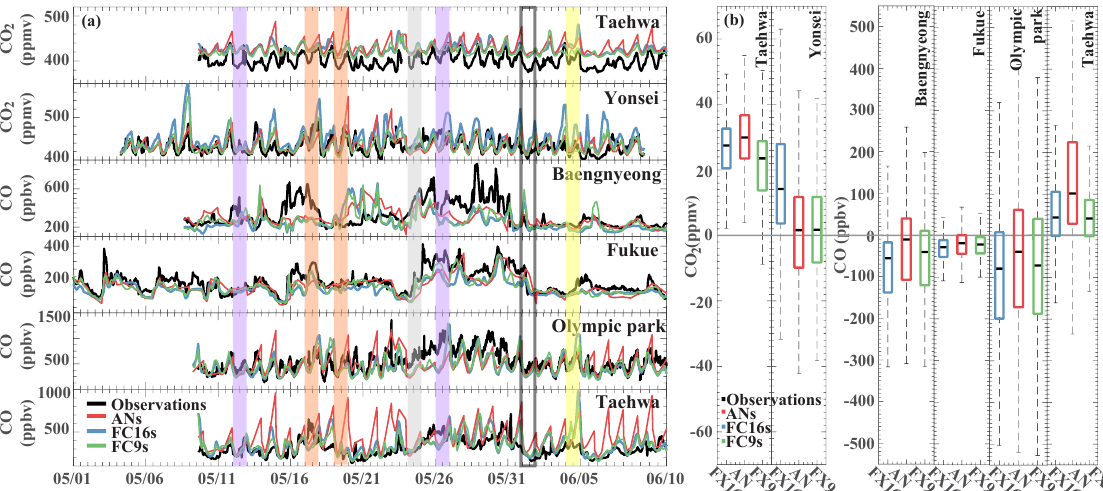
Figure 8. Comparisons of CAMS against ground site measurements. Values of CAMS are averages across layers with pressure higher than 95% of the surface pressure. (a) Time series of measured and CAMS CO 2 from the Taehwa and Yonsei sites, and CO from the Baengnyeong, Fukue, Olympic Park, and Taehwa sites. Shades denote same events as they do in Fig. 2. (b) Box plot of CAMS bias for CO 2 at the Taehwa and Yonsei site measurements, and for CO at the Baengnyeong, Fukue, Olympic Park, and Taehwa sites. Dates are in mm/dd